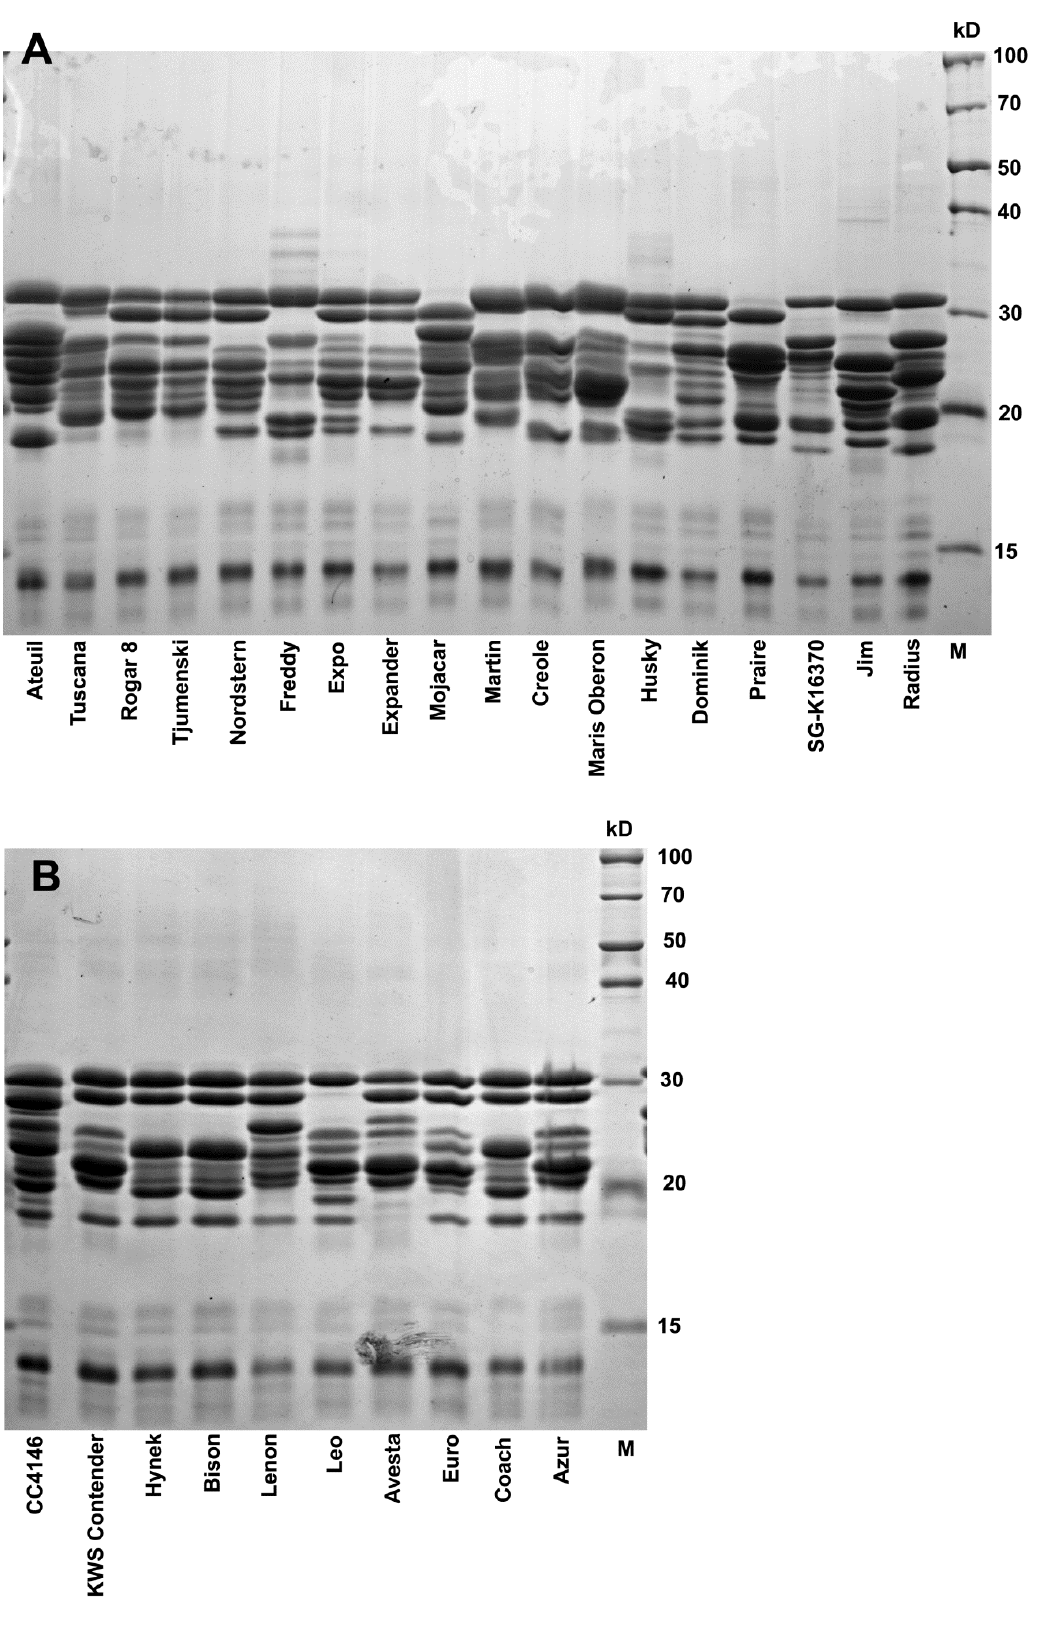
Figure 4. Electrophoretic 14% SDS-PAGE gel visualization of isolated avenin extracts in two groups of oat cultivars with a lower ( A ) and higher gluten (G12) peptide content ( B ).